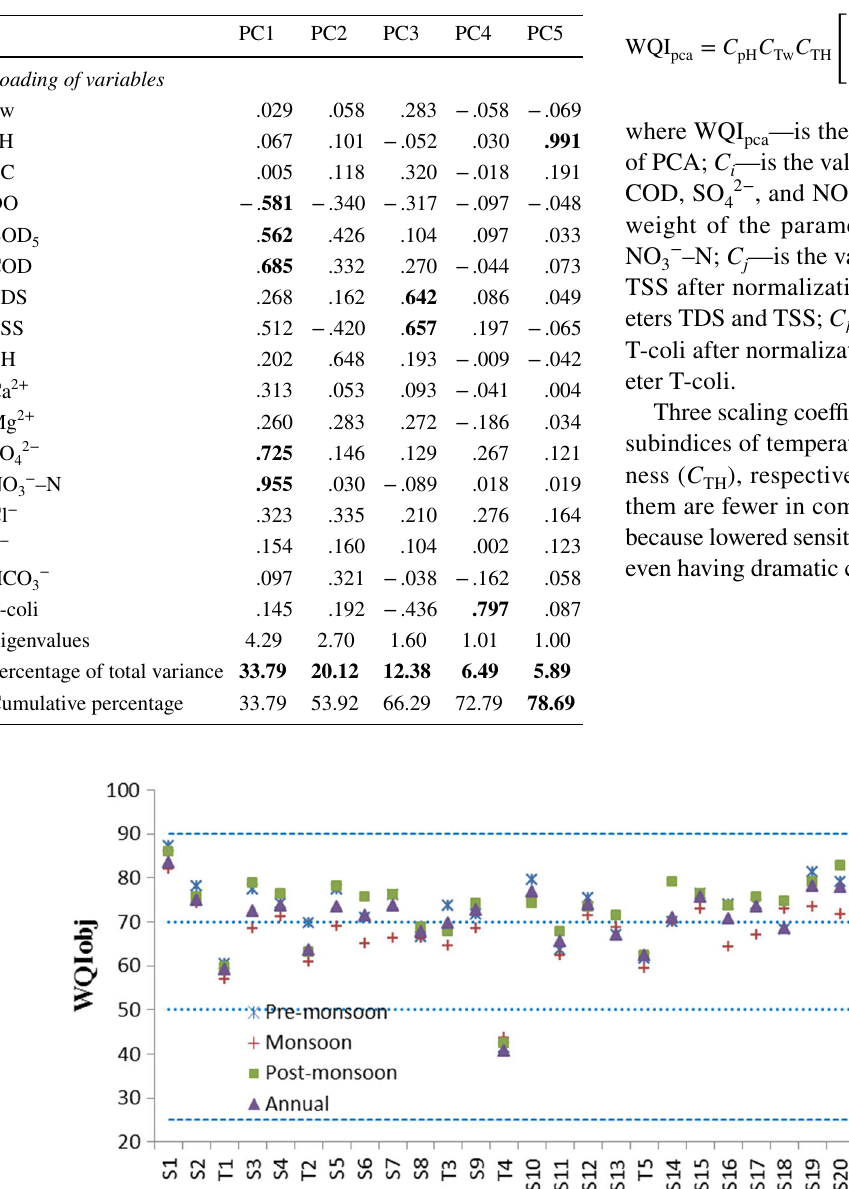
obj at 35 sites in upper